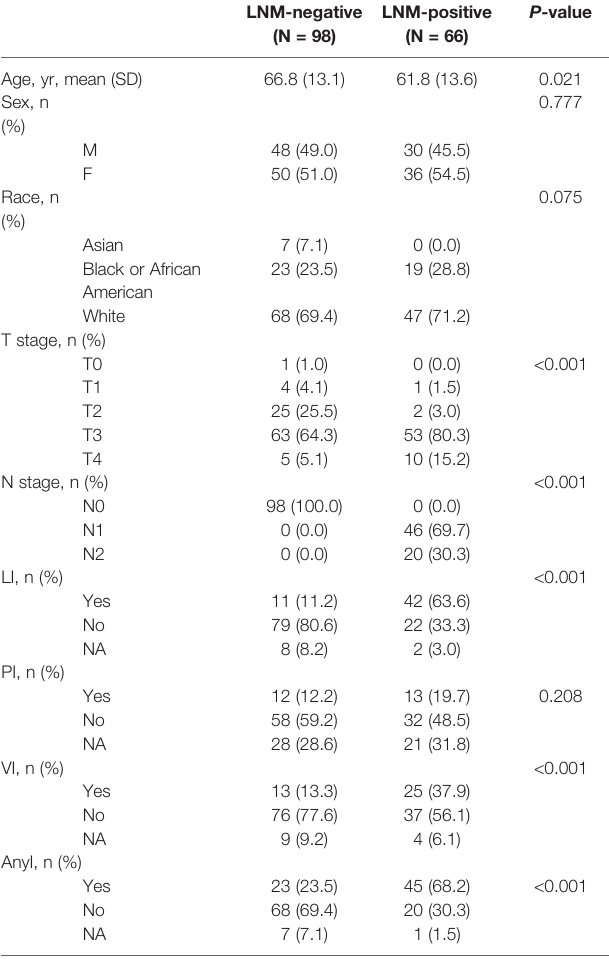
TABLE 1 | Clinical and pathologic characteristics of the included patients with colon cancer.